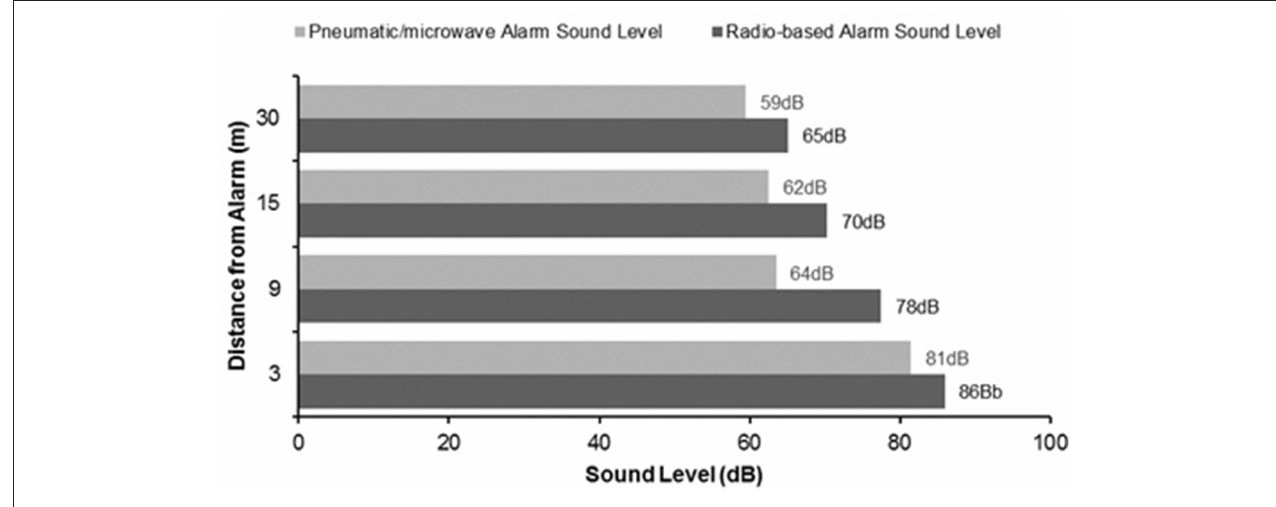
FIGURE 4 | Sound level of the radio-based and pneumatic/microwave alarms.